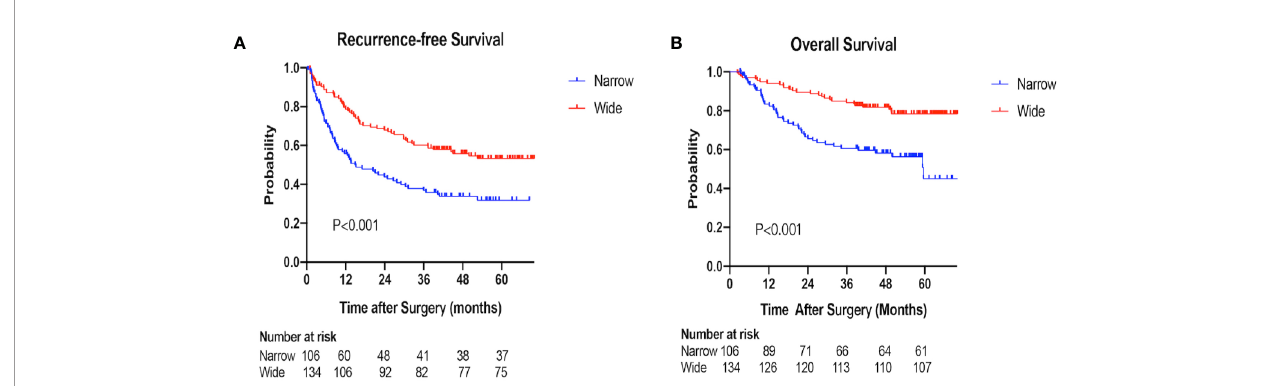
FIGURE 2 | Recurrence-free survival (RFS) and overall survival (OS) of the narrow-margin and wide-margin groups. (A) Recurrence-free survival for patients with narrow and wide margin resection. (B) Overall survival for patients with narrow and wide